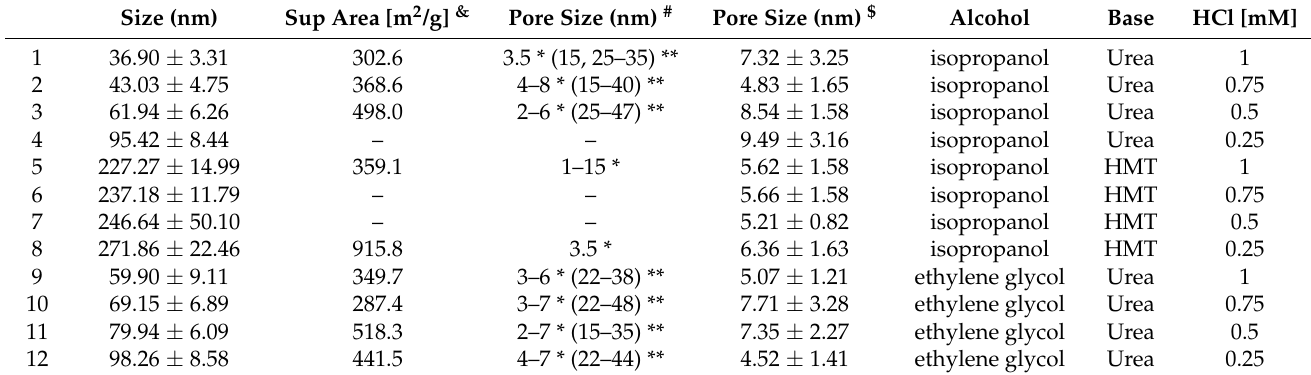
Figure 4. N 2 adsorption–desorption isotherm for WMS systems synthesized with different HCl concentrations. The systems synthesized with 1 mM HCl, and ( A ) isopropanol as a co-solvent and urea as a base, ( B ) isopropanol as a co-solvent and HMT as a base, and ( C ) ethylene glycol as a co-solvent and urea as a base. The systems synthesized with 0.25 mM HCl, and ( D ) isopropanol as a co-solvent and urea as a base, ( E ) isopropanol as a co-solvent and HMT as a base, and ( F ) ethylene glycol as a co-solvent and urea as a base. Table 1. Superficial area and porous properties of WMS systems synthesized with different HCl concentrations and varying co-solvents and bases.